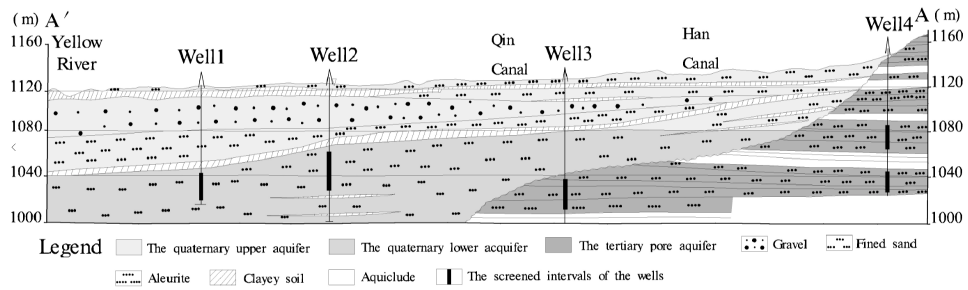
Figure 3. The hydrogeological profile of the study area.